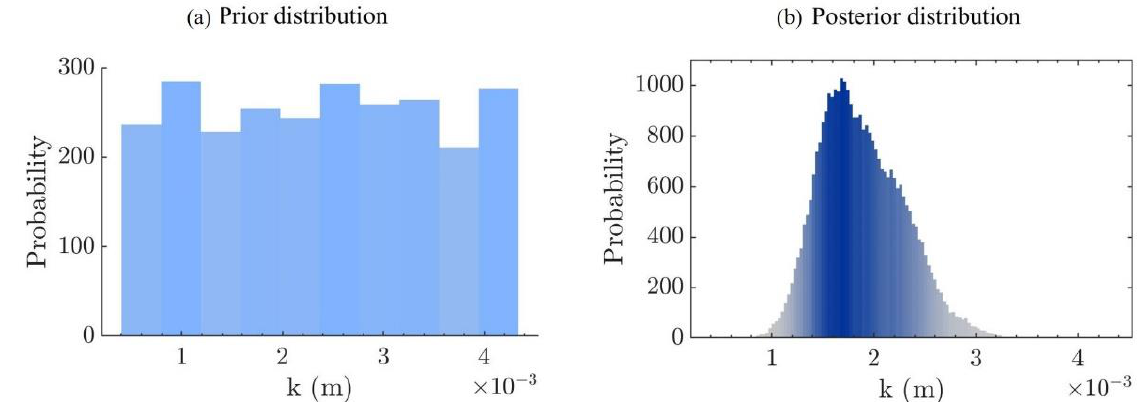
Figure 7. Prior ( a ) and posterior ( b ) distributions for the roughness height k ( M 3 calibration).